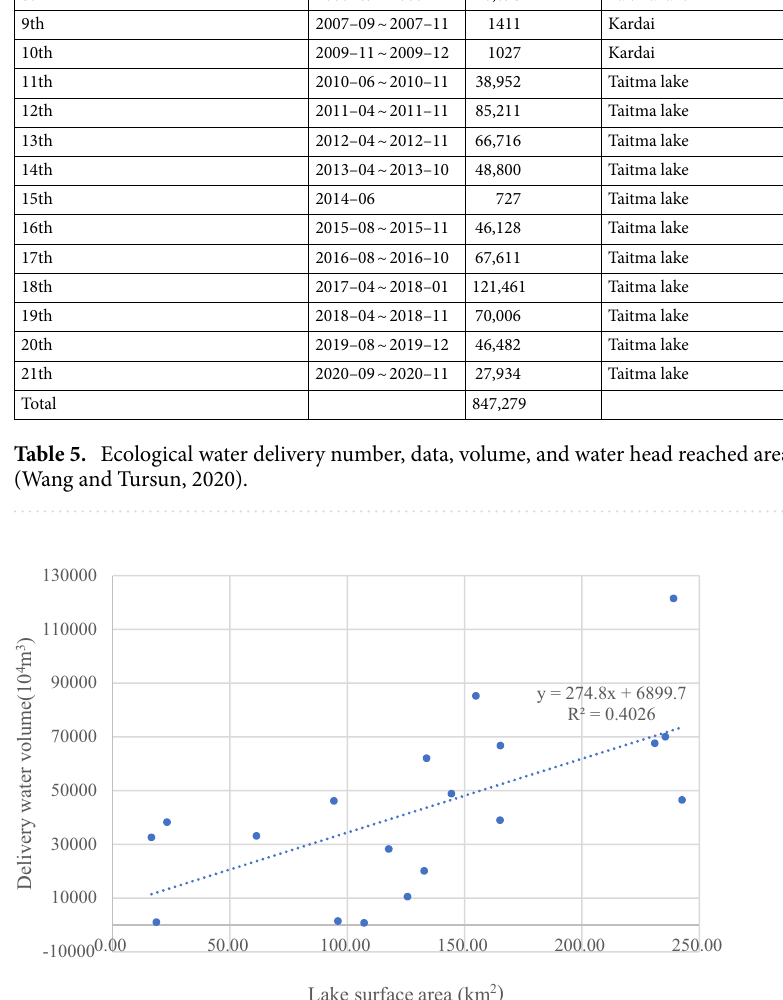
Figure 5. Linear correlation between surface water area of Taitema Lake and the total annual volume of ecological water delivery of Tarim